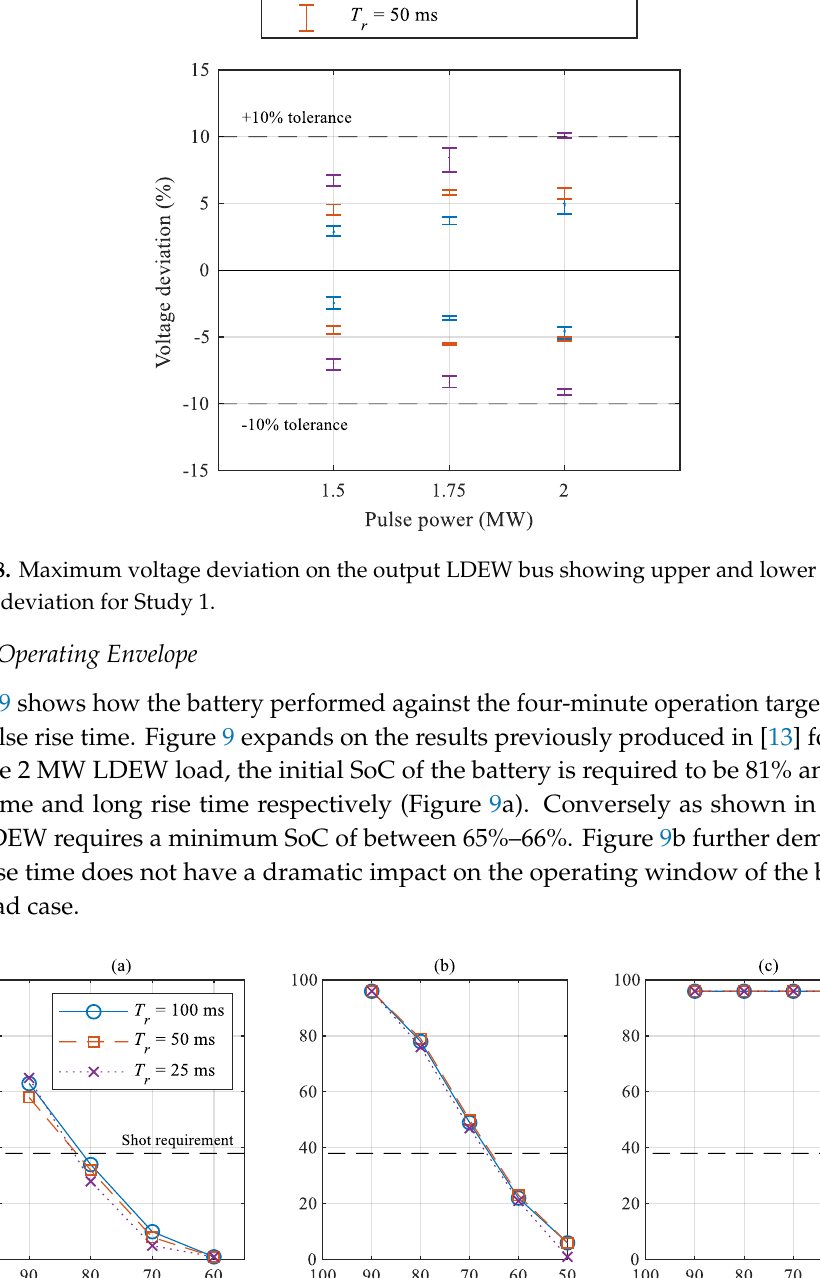
Figure 9. Battery shot performance against pulse rise time and sustained four minute operation target for ( a ) 2 MW ( b ) 1.75 MW and ( c ) 1.5 MW LDEW load.